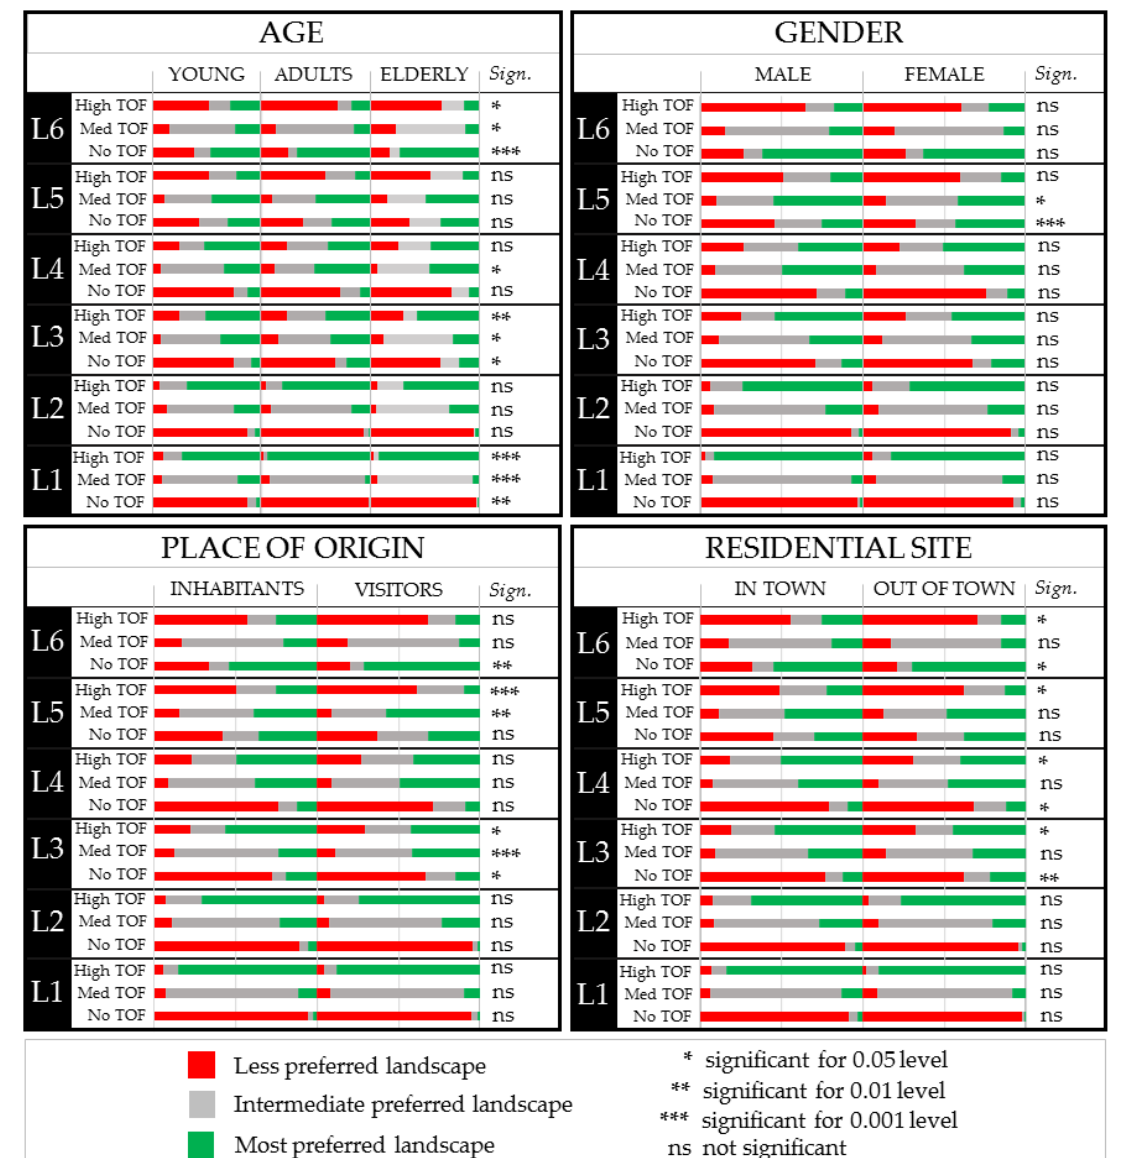
Figure A1. Between groups’ preference distributions (i.e., age, gender, place of origin and residential site). For each landscape, on the right of between groups’ distributions, significance level of the χ2 test is shown.